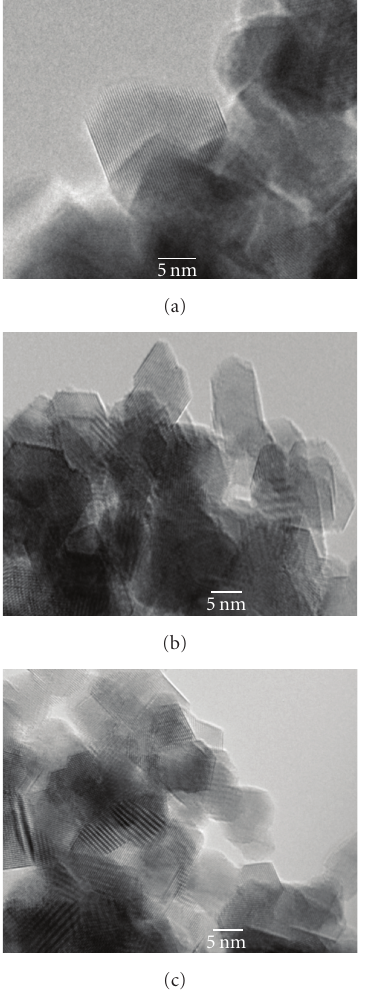
Figure 4: TEM images of sulfided Ru (a), Pd (b), and Rh (c); bar: 5nm.